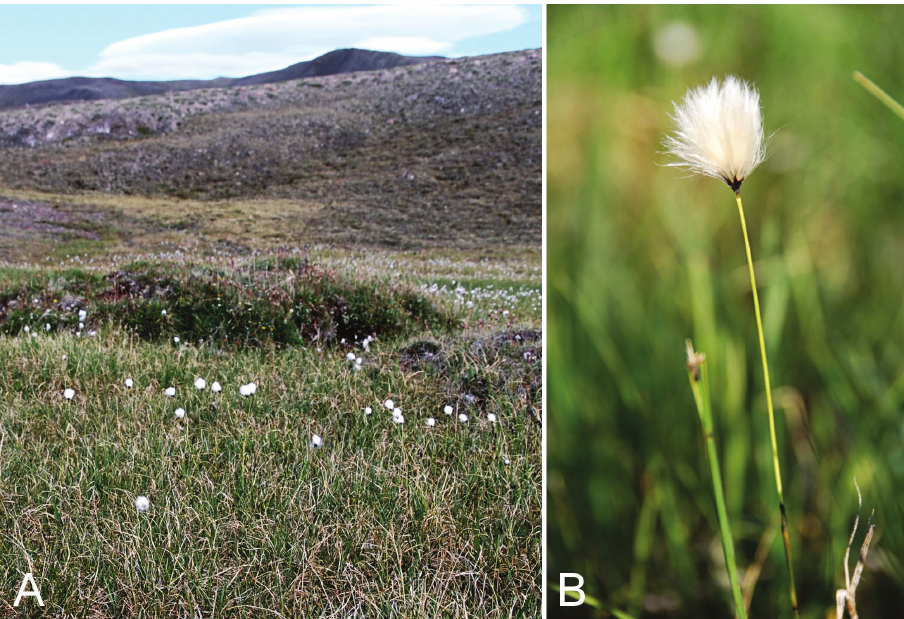
Figure 3. Eriophorum brachyantherum : A habitat B inflorescence, Saarela et al. 9899 . Photographs by J.M. Saarela